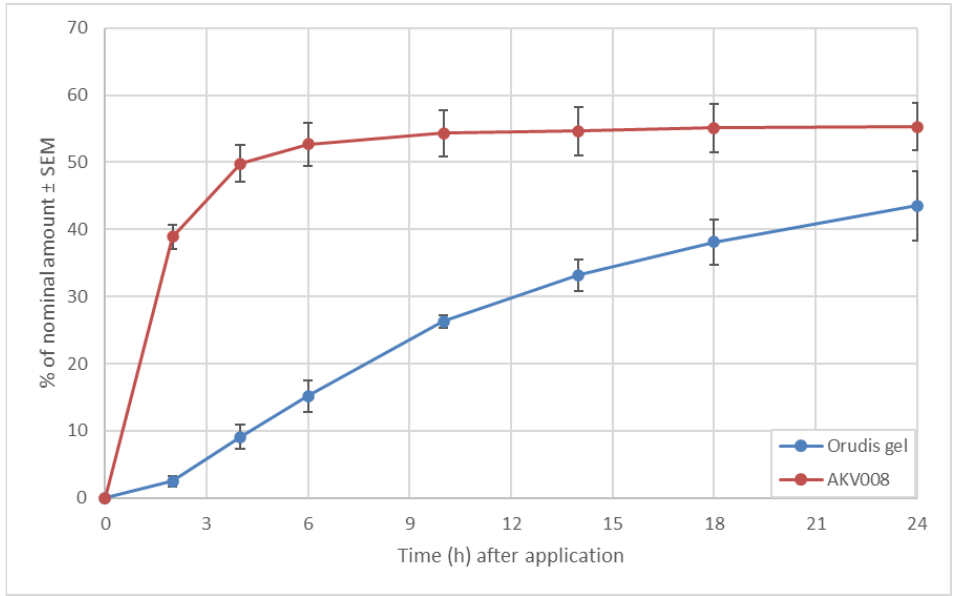
Figure 9. Cumulative permeation of ketoprofen through Strat-M membranes.